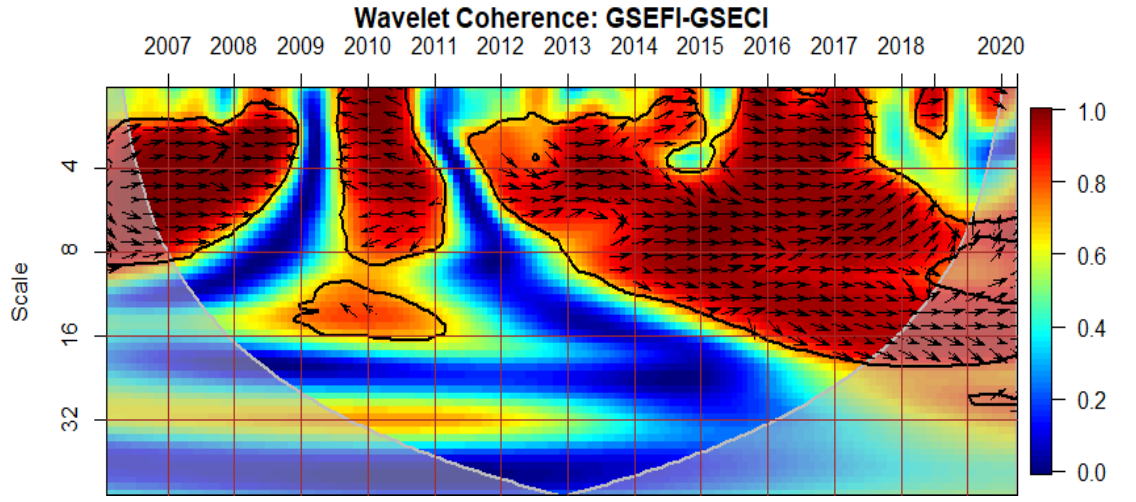
Figure 15. Comovements between the indicators of the